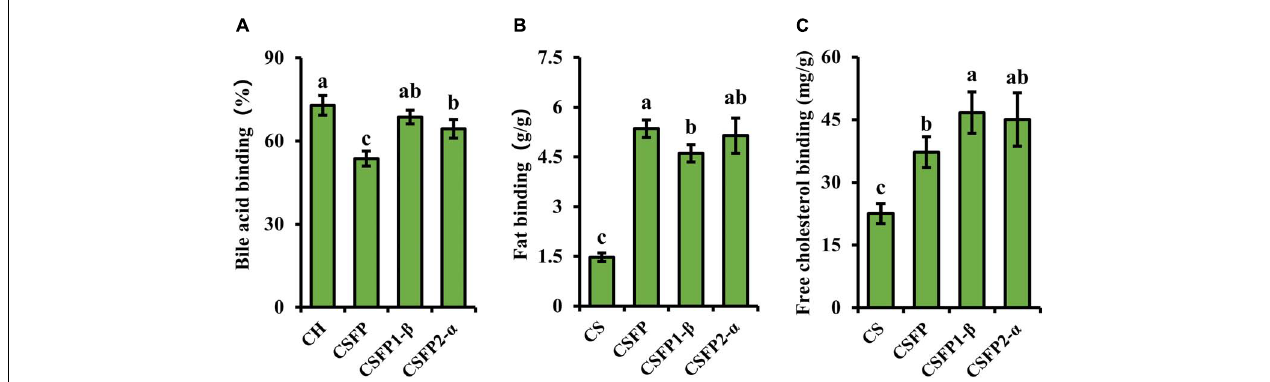
FIGURE 7 | Binding ability of CSFP, CSFP1- β , and CSFP2- α in vitro . (A) Bile acid, (B) Fat, and (C) Free cholesterol. Data are expressed as the mean ± standard deviation ( n = 3) values, and different lowercase letters denote statistical significance ( p < 0.05).